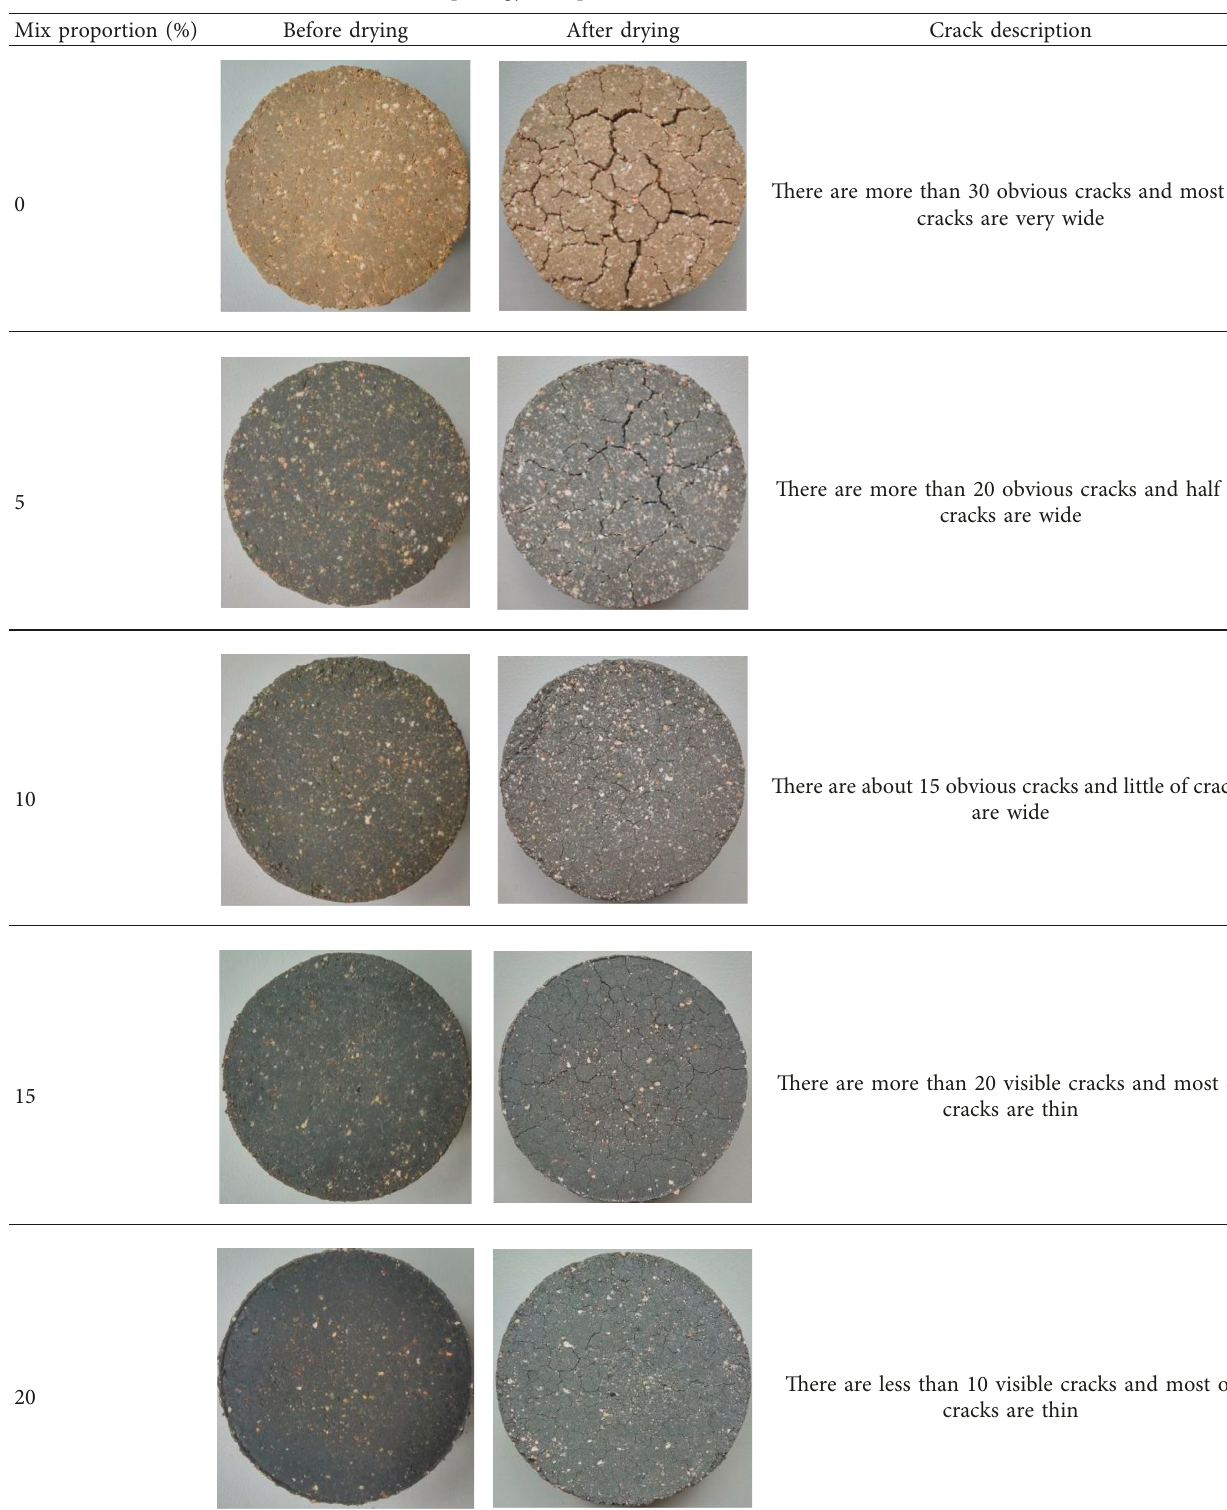
Table 4: Crack morphology of expansive soil with different RHA-lime